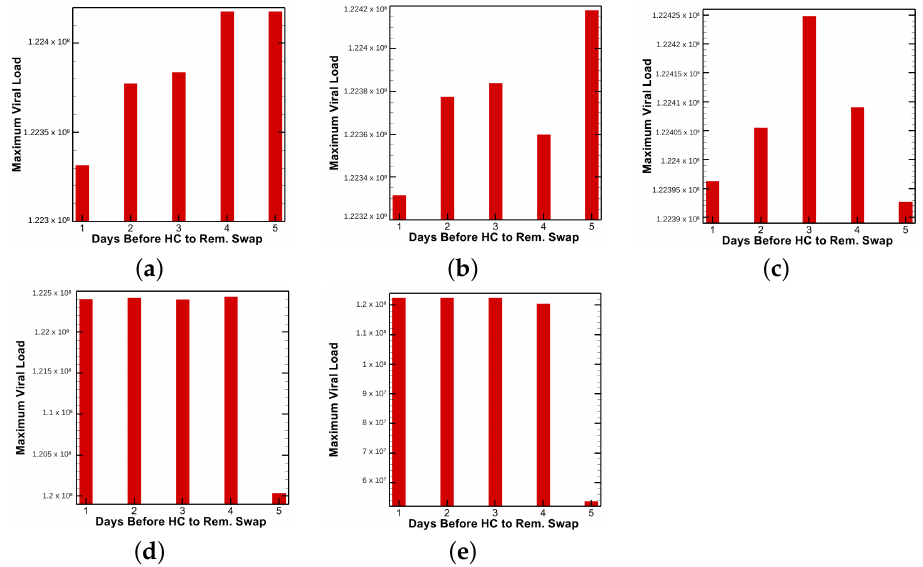
Figure 11. Maximum viral load observed for various treatment timing configuration of host-cell entry inhibitor followed by Remdesivir with patient vaccine efficacies of ( a ) 0.1, ( b ) 0.125, ( c ) 0.150, ( d ) 0.1625 and ( e )